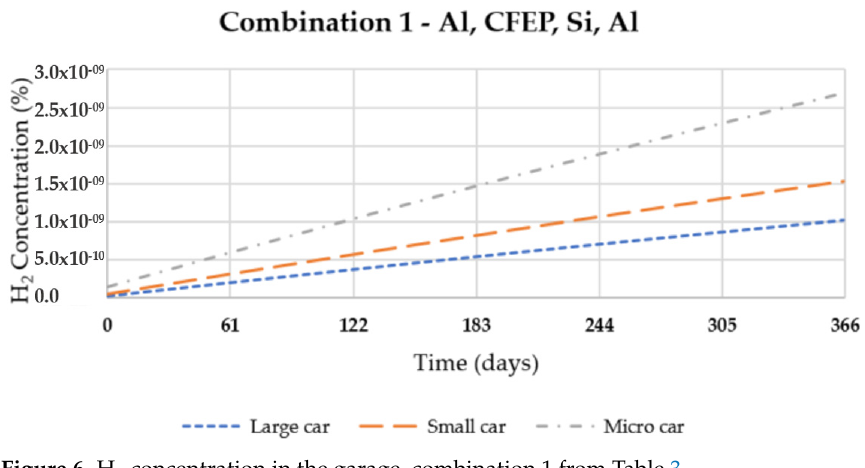
Figure 5. Pressure inside of the spheres and the envelope tank, combination 19 from Table 3.